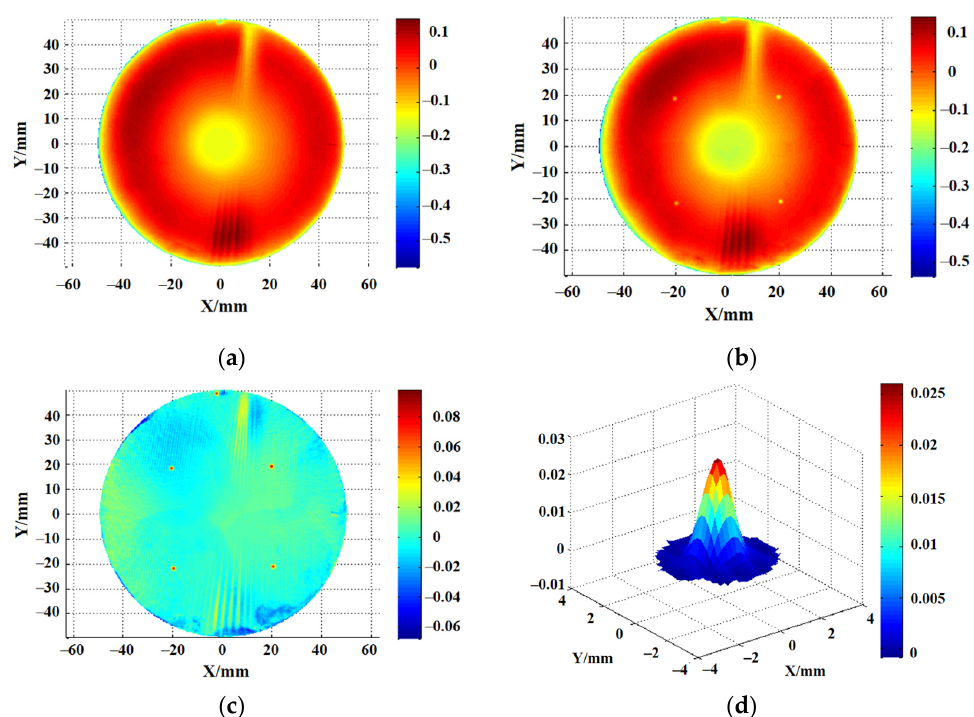
Figure 1. Material removal resolution of IBF: ( a ) the initial surface; ( b ) removed surface; ( c ) surface subtraction; ( d ) 3.3 mm removal function.